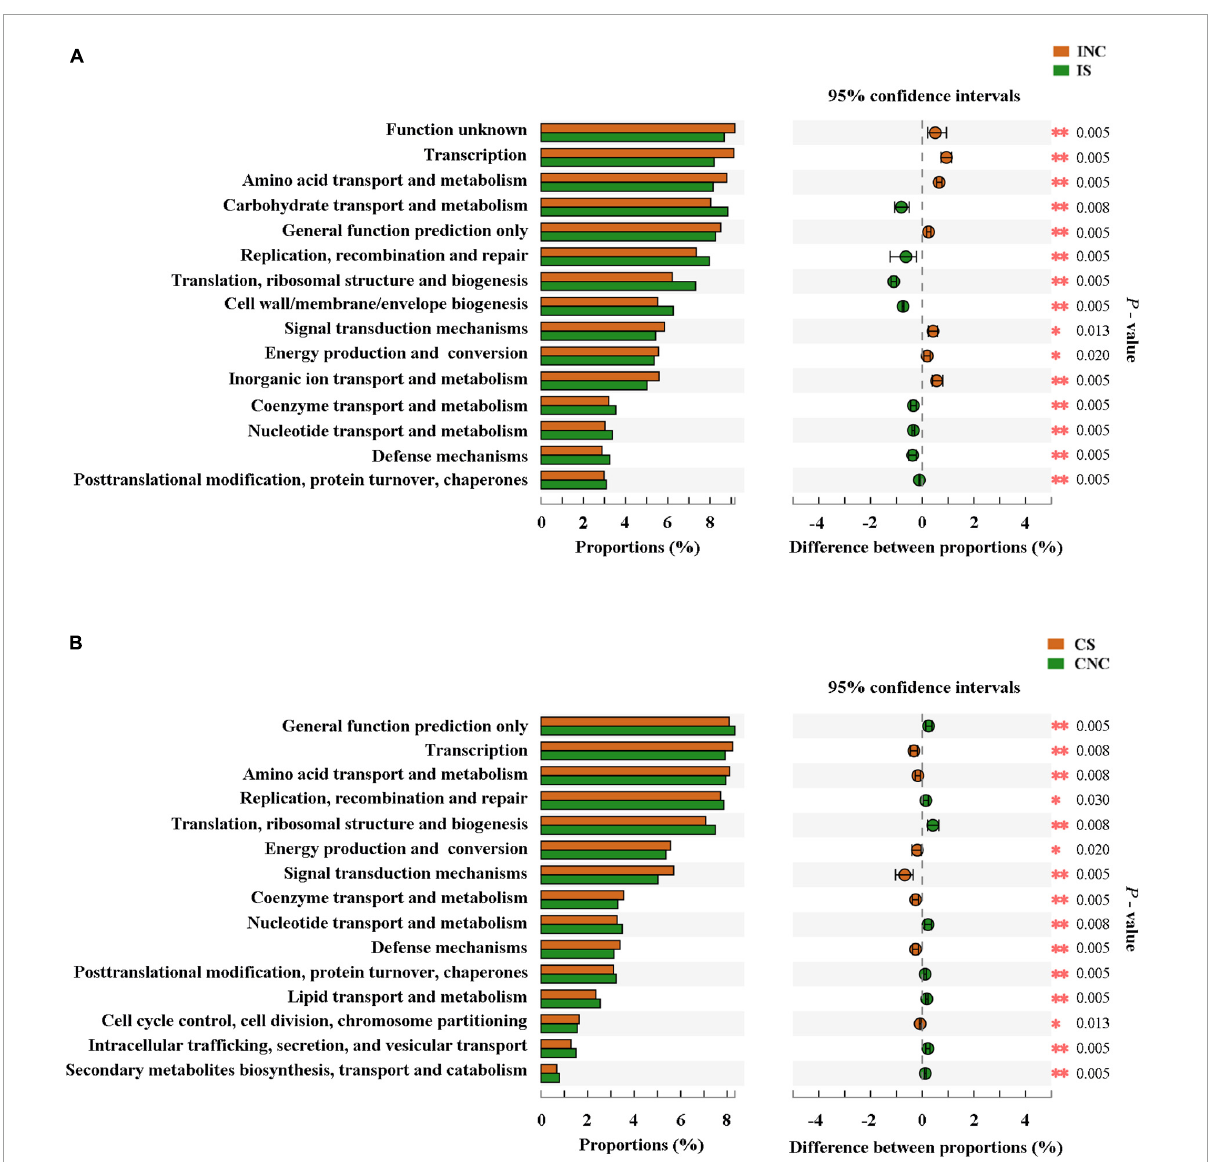
FIGURE6 Comparison of the bacterial predicted biological functions (COG level 1) between the control and treatment group from the ileum and the colon using PICRUSt. (A) COG function prediction analysis of ileal bacteria between INC and IS. (B) COG function prediction analysis of colonic bacteria between CNC and CS. INC, ileum negative control; CNC, colon negative control; IS, ileum with 0.2% sodium butyrate; CS, colon with 0.2% sodium butyrate. ∗ P < 0.05 and ∗∗ P <